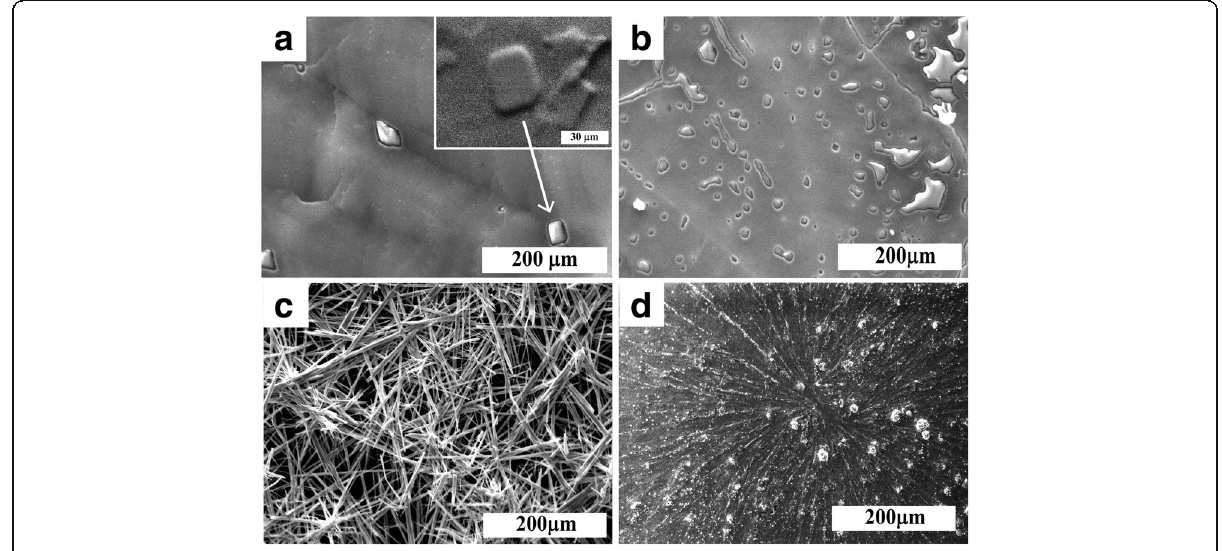
Fig. 2 Images of CH 3 NH 3 I ( a , b ) and PbI 2 ( c , d ) films without heating ( a , c ) and after thermal treatment at 90 ° С ( b , d ), deposited on glass substrates. Inset in a — increased SEM-BSE image of